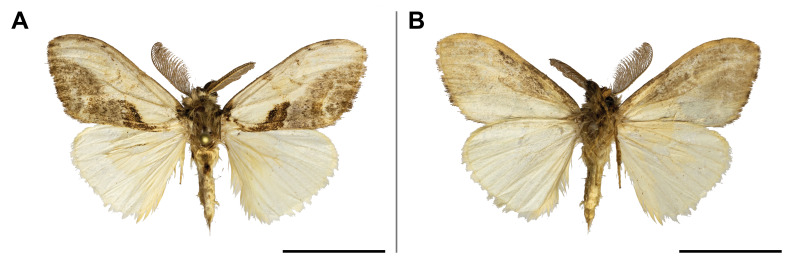
Orgyia
basalis (Walker, 1855). A. dorsal view; B. ventral view. The scale bar represents 1 cm.